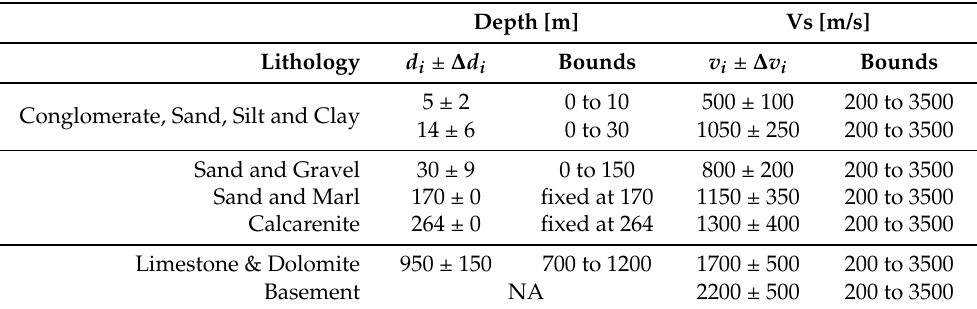
Table 2. Well-log lithology and HVSR inversion initial Vs models from the EJDN station are sum- marized. Initial models were generated randomly in the Vs range v i ± ∆ v i and bottom depth range d i ± ∆ d i . During the inversion, model parameters had to remain within the given bounds.